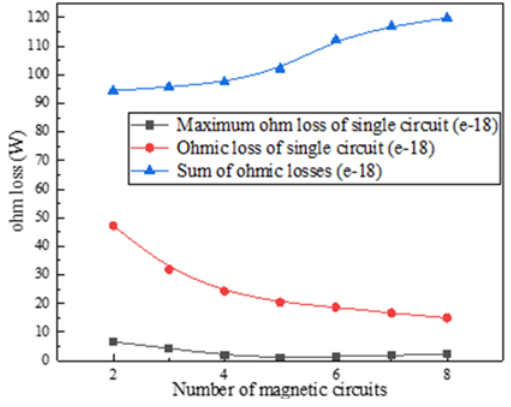
Figure 14. Ohmic loss of different circuits.